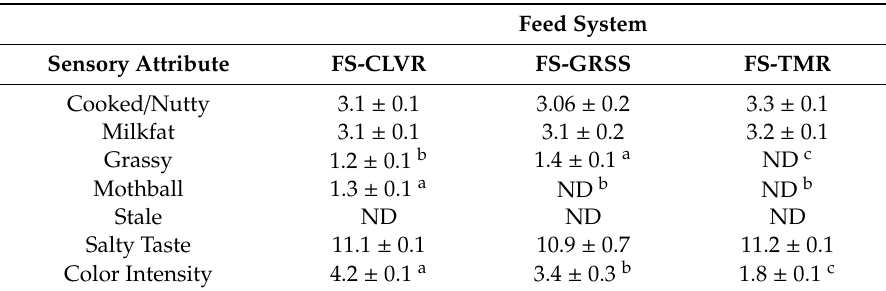
Table 3. Sensory attribute means from trained USA panel evaluation of FS-GRSS, FS-CLVR and FS-TMR butters. Table presents DA averages and standard